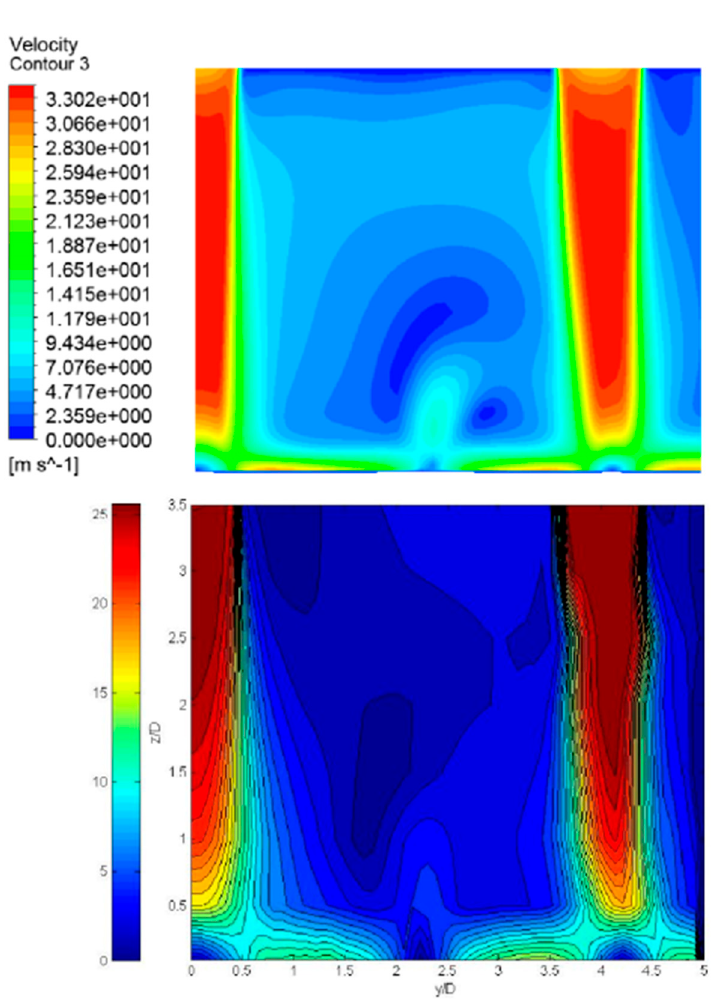
Figure 10. Velocity contours for the plane x / D = 0 (numerical above, experimental below).